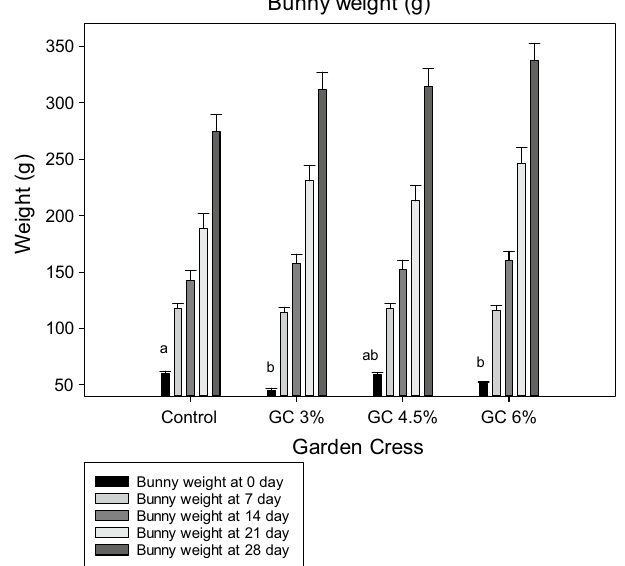
Figure 1. Effect of dietary levels of garden cress seeds on bunny weight of doe rabbits.